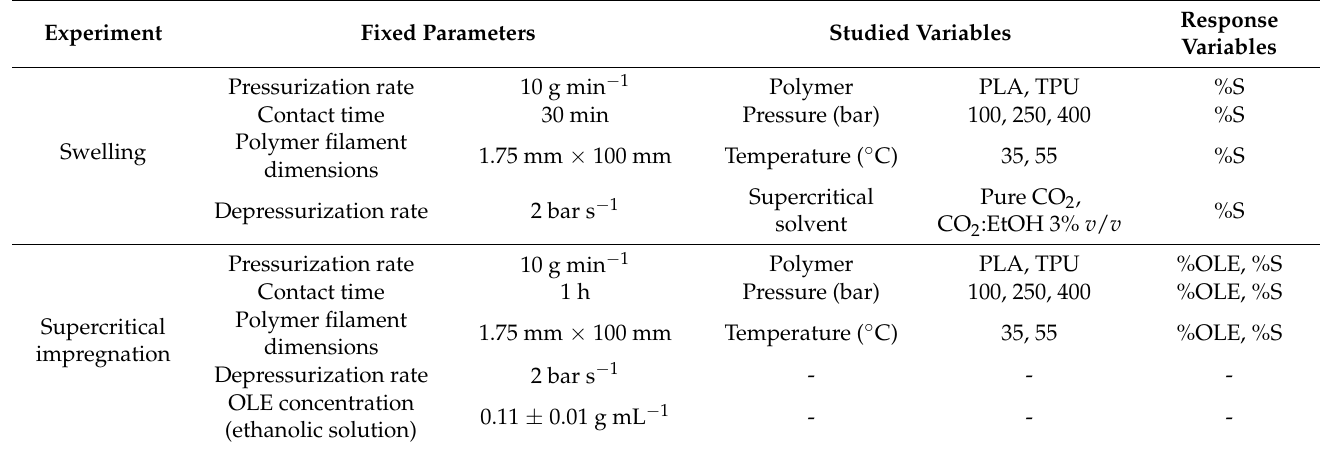
Table 2. Design of experiments for the polymer swelling degree (%S) and ethanolic OLE loading